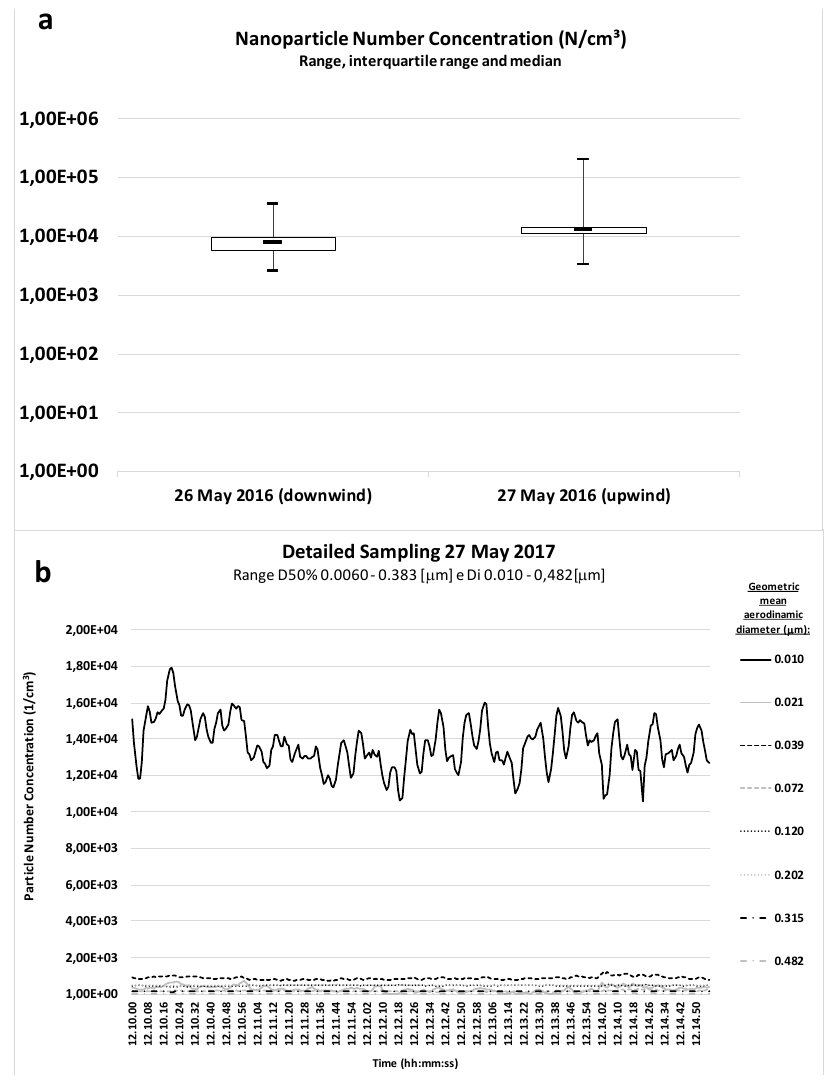
Figure 4. Particles number during the inert bomb launch ( a ). The lower picture ( b ) shows a representative UFPs count distribution by time of the day.